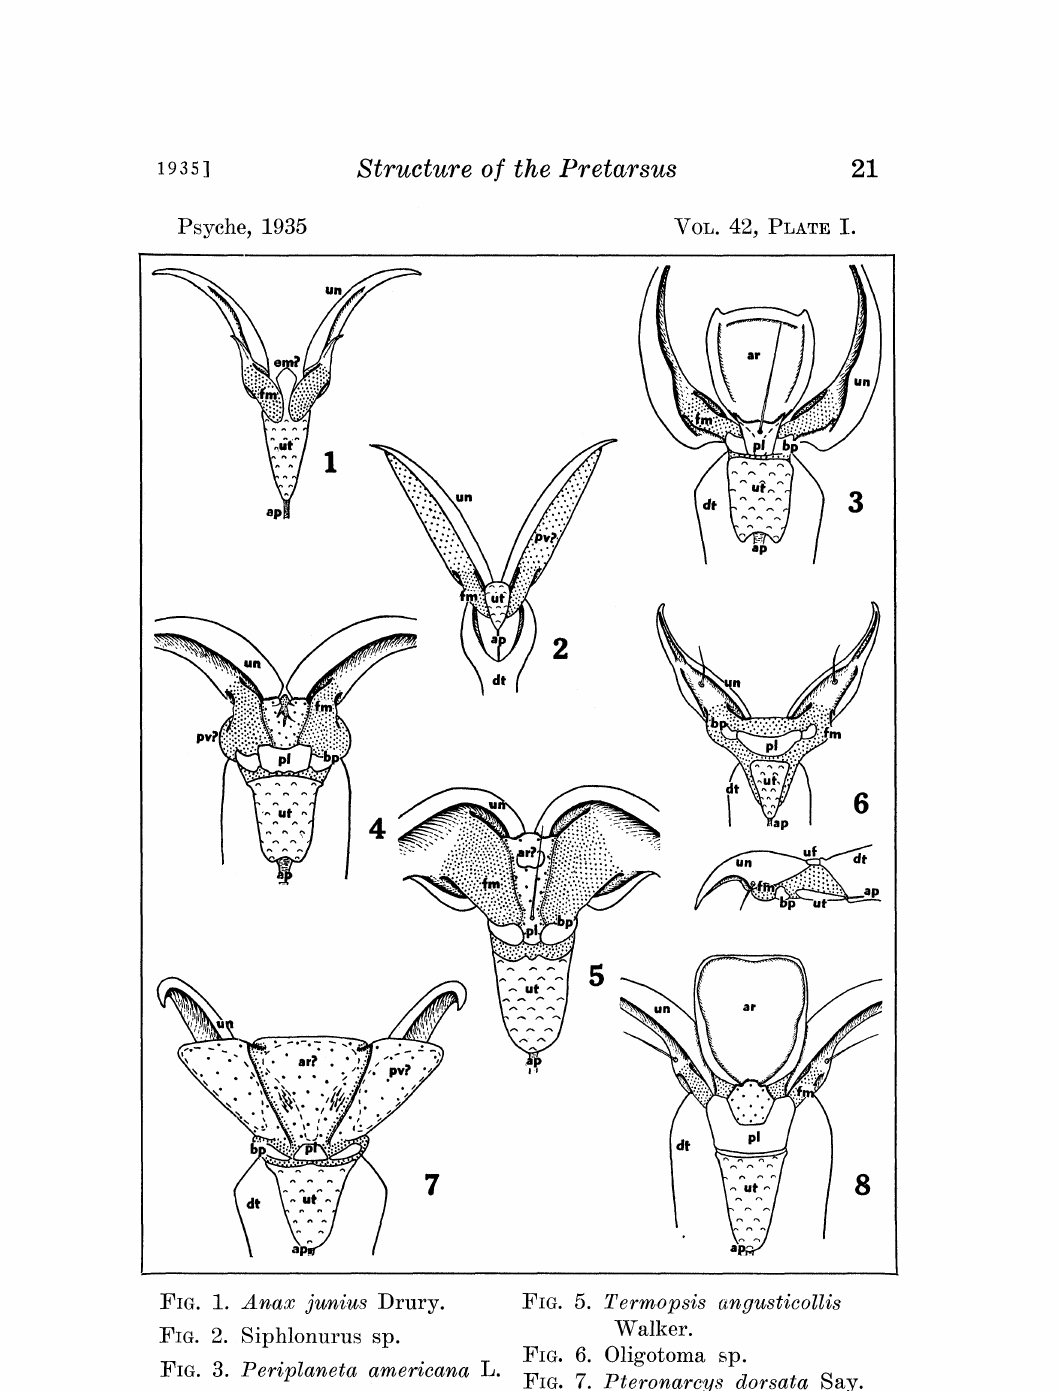
FIG-. 1. Anax junius Drury. FIG. 5. Term.opsis angusticollis FIG. 2. Siphlonurus sp. Walker. FIG. 6. 01igotoma sp. FIG. 3. Periplaneta americana L. FIG. 7. Pteronarcys dorsata Say. FIG. 4. Tenodera sinensis Sauss. FIG. 8. Melanoplus bivittatus